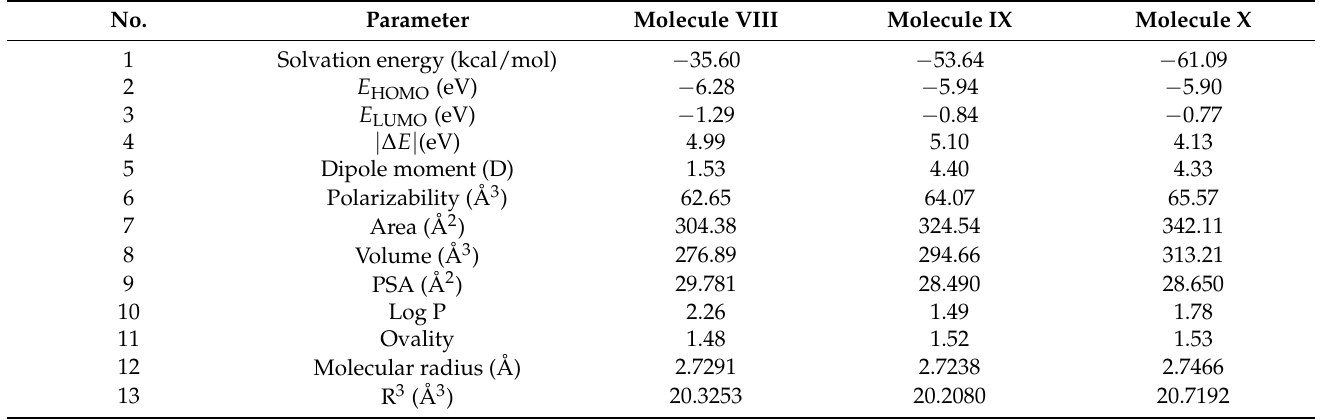
Figure 4. Optimized structure of molecules VIII ( a ), IX ( b ), and X ( c ). The values of some electro-optical parameters computed using Spartan’14 for the studied molecules are given in Table 7. Table 7. Molecular parameters computed by Spartan’14.